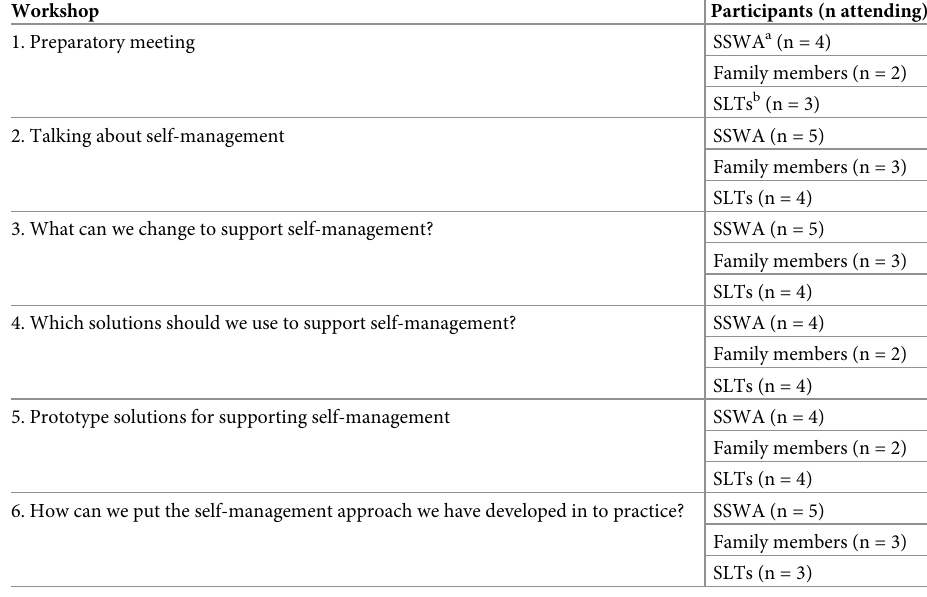
Table 3. Overview of group